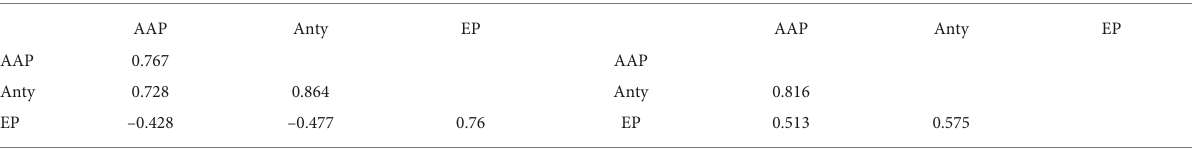
TABLE 4 Discriminant validity.